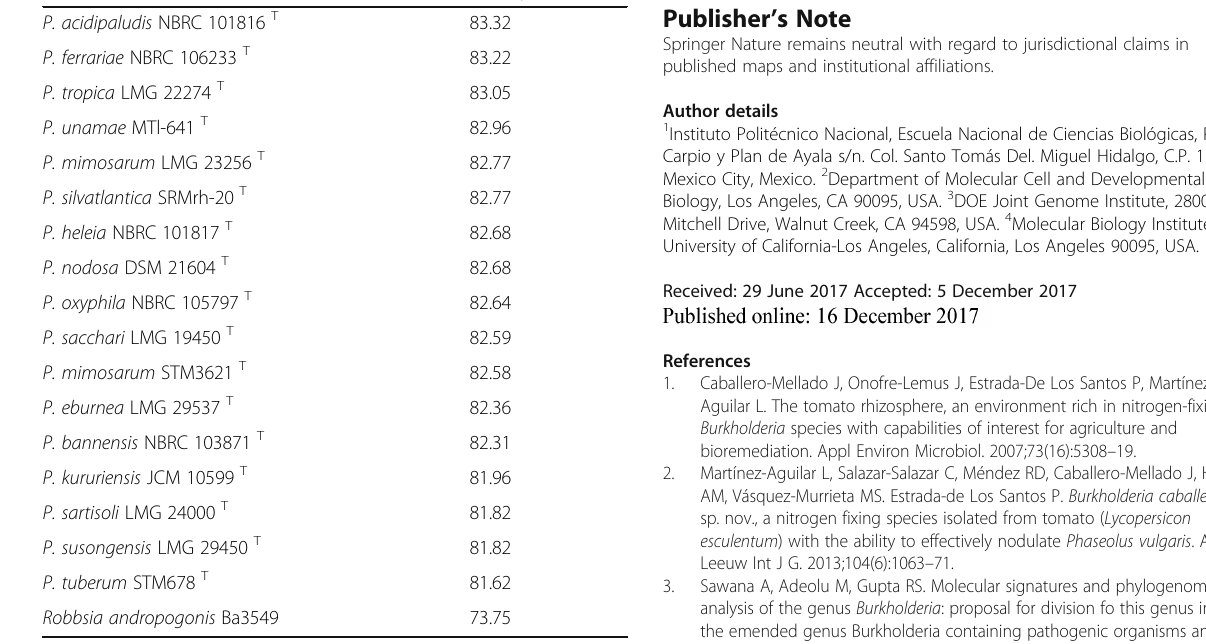
Table 5 Average nucleotide identity of strain TNe-841 T with Paraburkholderia species genome Paraburkholderia